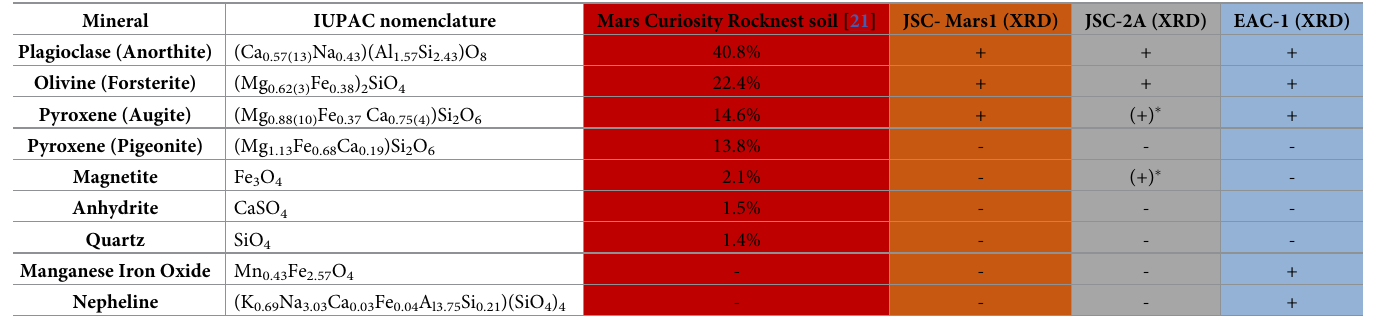
Table 3. X-ray diffraction analysis of the Mars Rocknest soil [21] and the three different regolith simulants.